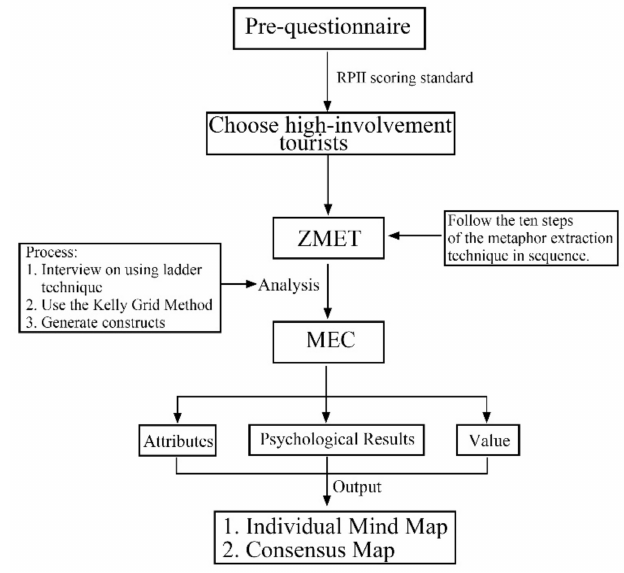
Figure 2. Flow chart of metaphor extraction technique.